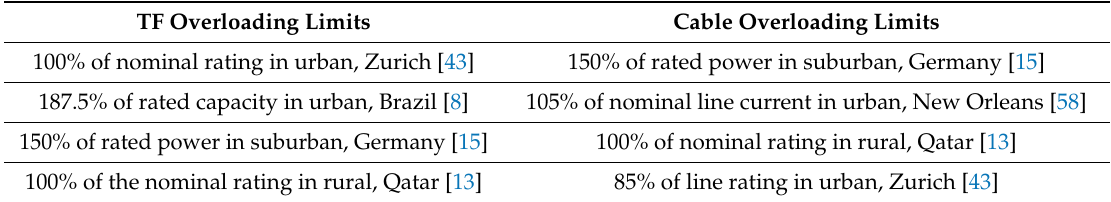
Table 3. A comparison of PV HC limited by overloading of transformers and cables in literature showing cable ampacity being more conservative as compared to transformer overloading